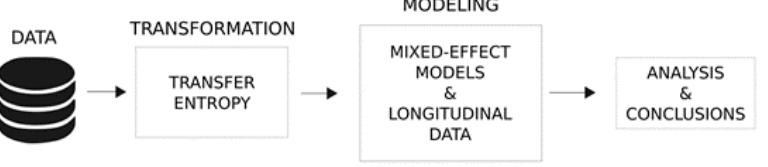
Figure 3. Visual summary of the methodological framework. Acquired data transformation was obtained by using the bi-dimensional time series related to the vertical platform (Fz) from the right and left side, then summarizing each piece of transference information as a complexity measure (using the transfer entropy). After summarizing these data into single values, they were compared using a Mixed-Effect Model (GLMM, Gamma Regression), as a longitudinal study. Then, analysis and conclusions were